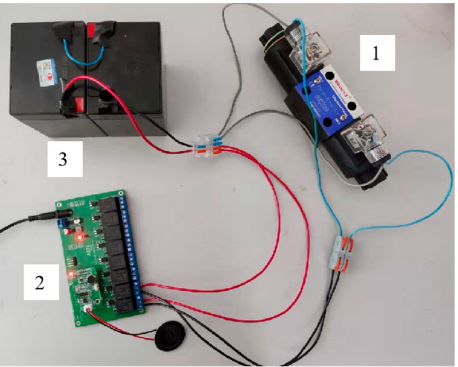
Figure 12. Voice test system of operation. 1 represents the solenoid directional valve, 2 represents the voice control module, and 3 represents the battery.